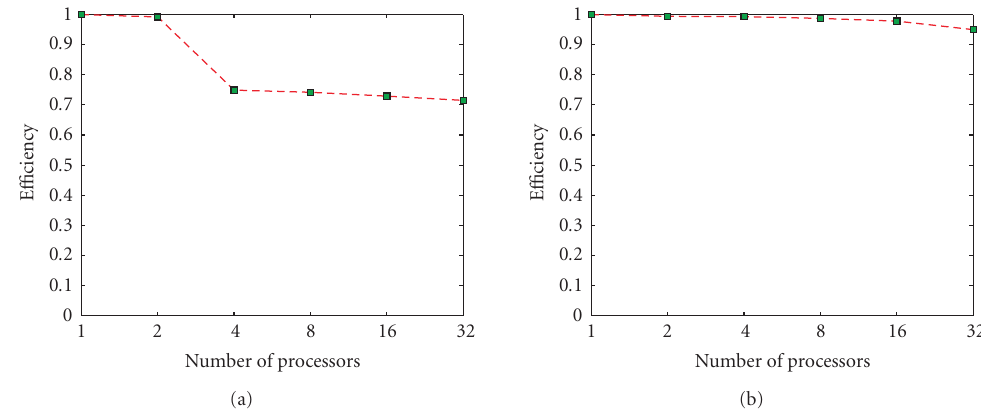
Figure 8: (a) E ffi ciency with the uniform partition of I ; (b) e ffi ciency with the nonuniform partition of I . The e ffi ciency with nonuniform partition of I is better than that with the uniform partition of I .